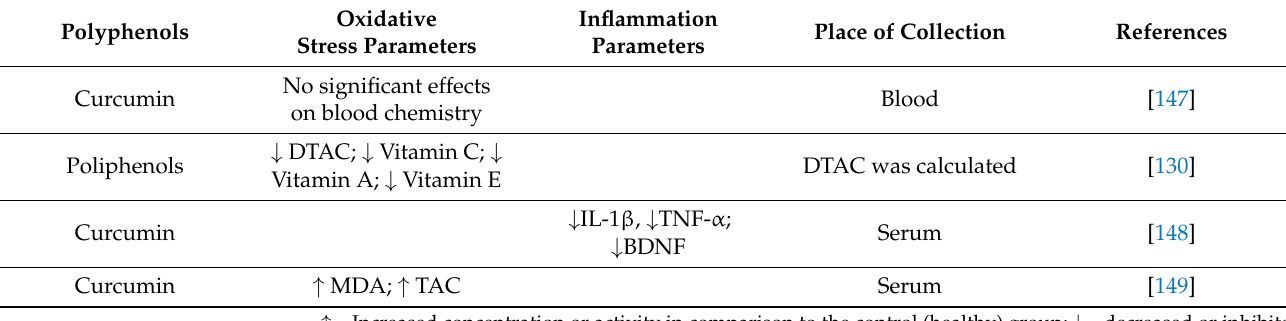
Table 2. The effect of polyphenols on oxidative stress in depression—review of studies in human. Polyphenols Oxidative Stress Parameters Inflammation Parameters Place of Collection